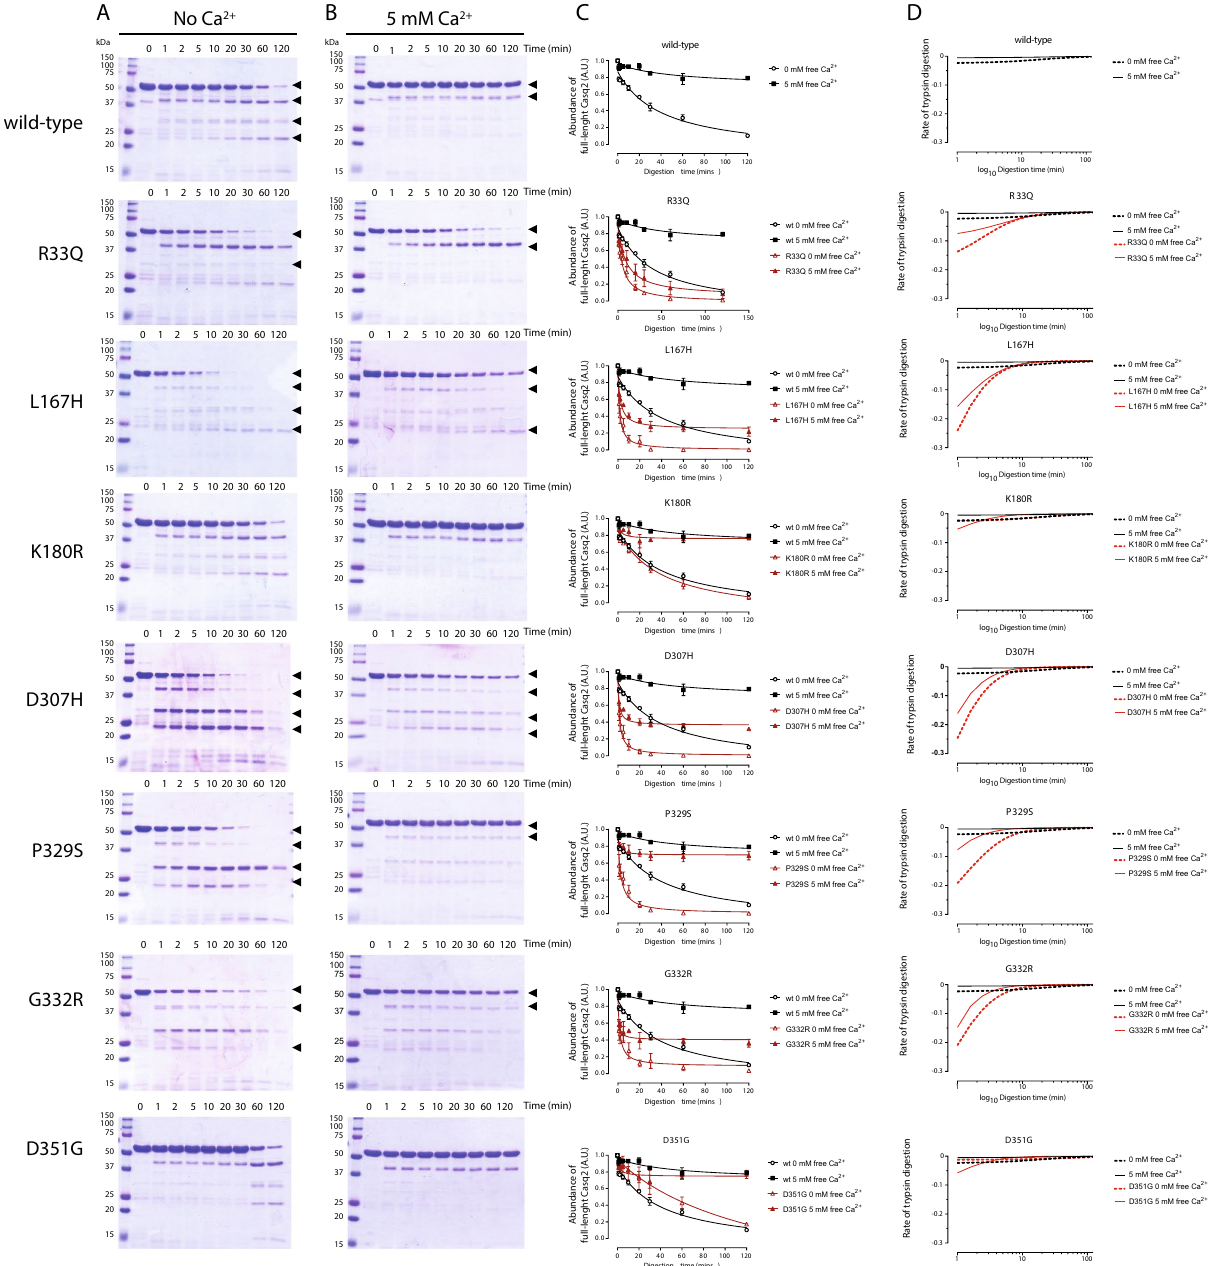
Figure 5. Limited trypsin digestion of Casq2 mutants. Wild-type Casq2 and Casq2 mutants were subjected to trypsin proteolysis in the absence ( A ) and presence ( B ) of 5 mM Ca 2+ followed by SDS-PAGE. The tryptic fragments, which differed from that of wild-type Casq2 are indicated by the arrowheads. ( C ) The rate of proteolysis of wild-type and mutant Casq2 as a function of time of trypsin digestion. ( D ) The rate of proteolysis plotted as the first derivative of the fitted curve from ( C